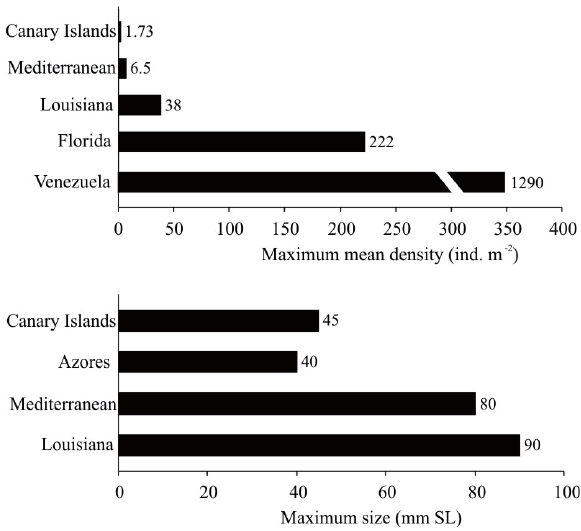
Fig . 4. − Ranges of mean abundances and sizes for Stramonita haemastoma in different coastal areas in atlantic ocean waters (northern hemisphere). data sources: Florida and Venezuela (but- ler, 1985), Gulf of mexico (brown and Richardson, 1987), azores (Spence et al. , 1990), mediterranean (Rilov et al. , 2001), canary islands (this